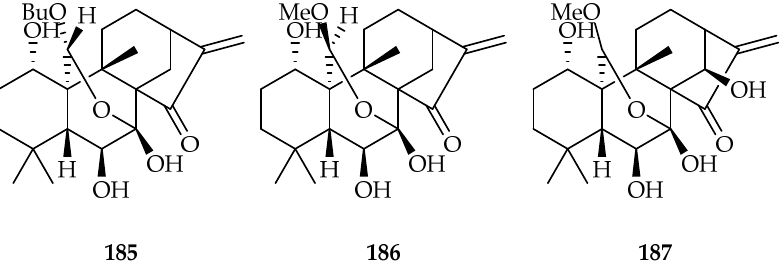
Figure 76. Structures of isojiangrubesins B 185 [121], isojiangrubesins C 186 [121], and isojiangrubesins E 187 [121].